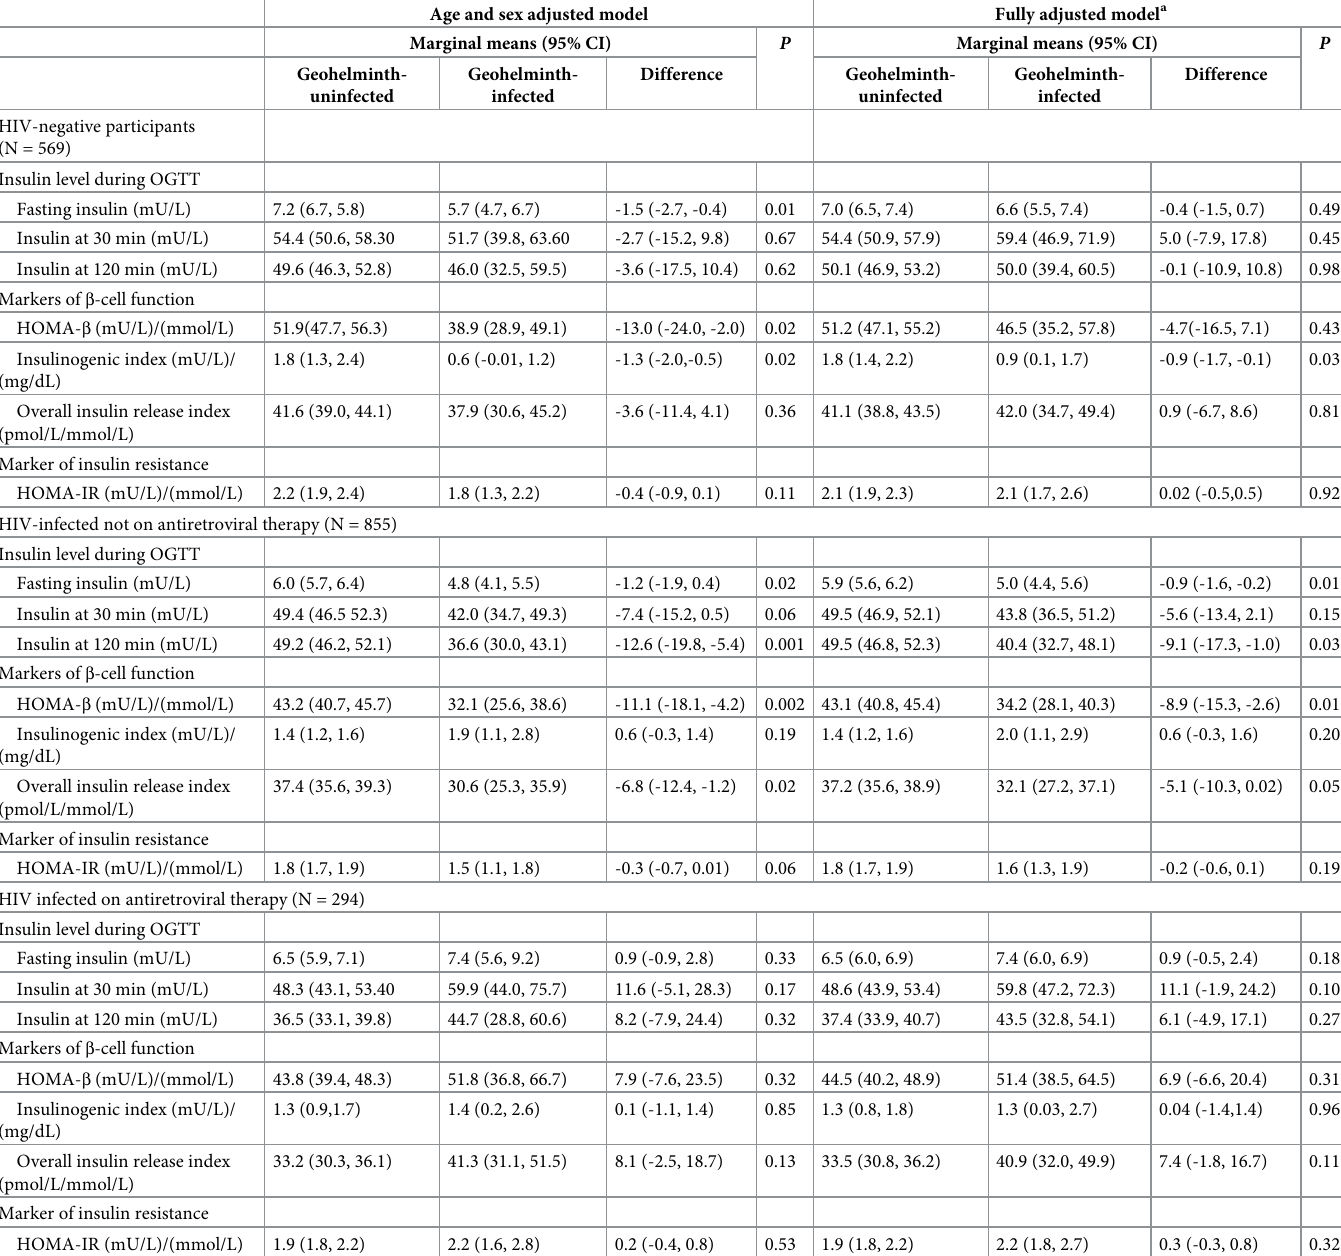
Table 3. Analysis of association of geohelminth infection with β -cell function and insulin resistance by HIV treatment status. Age and sex adjusted model Fully adjusted model a Marginal means (95% CI) P Marginal means (95% CI) P Geohelminth- Geohelminth- Difference Geohelminth- Geohelminth- uninfected infected uninfected infected